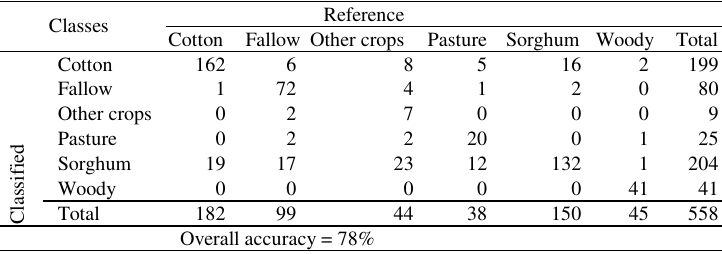
Table 4. Accuracy assessment of summer 2010 classification of